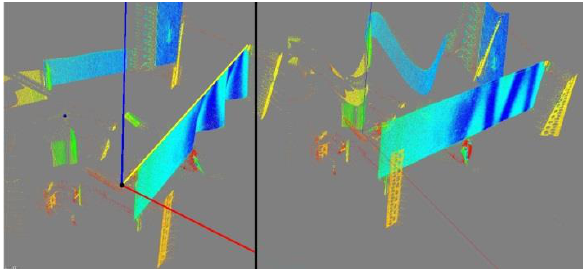
Figure 2: Object coordinate system and intensity coded point cloud before (left) and after geometric correction (right)